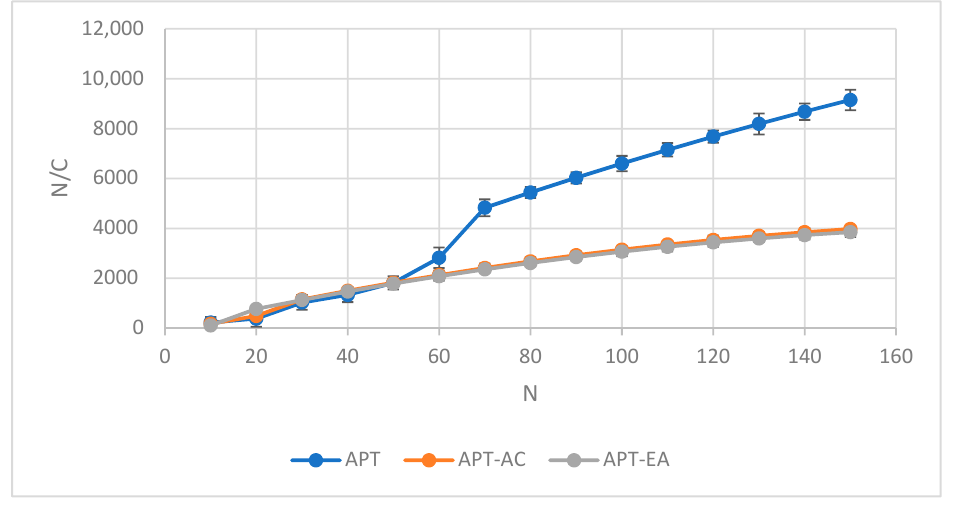
Figure 7. Kawakita plot. Table 3. Kawakita analysis.